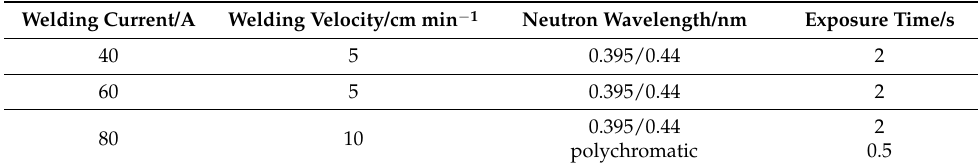
Table 2. Welding parameters and neutron imaging parameters.